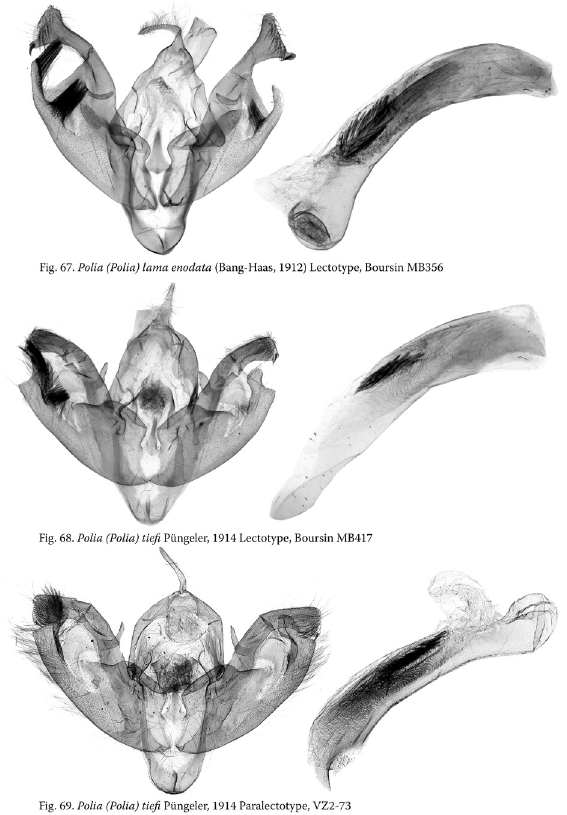
Figure 67–71. 67. Polia ( Polia ) lama enodata (Bang-Haas, 1912) Lectotype male. 68. Polia ( Polia ) tiefi Püngeler, 1914 Lectotype male. 69. Polia ( Polia ) tiefi Püngeler, 1914 Paralec- totype